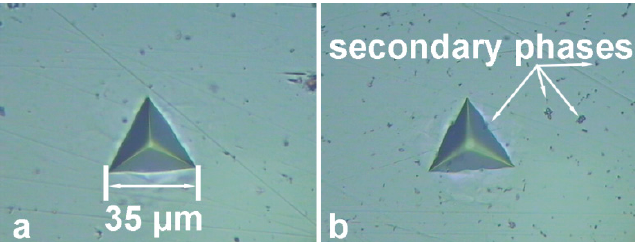
Figure 12. Test indentations in the BM ( a ) and HAZ ( b ).